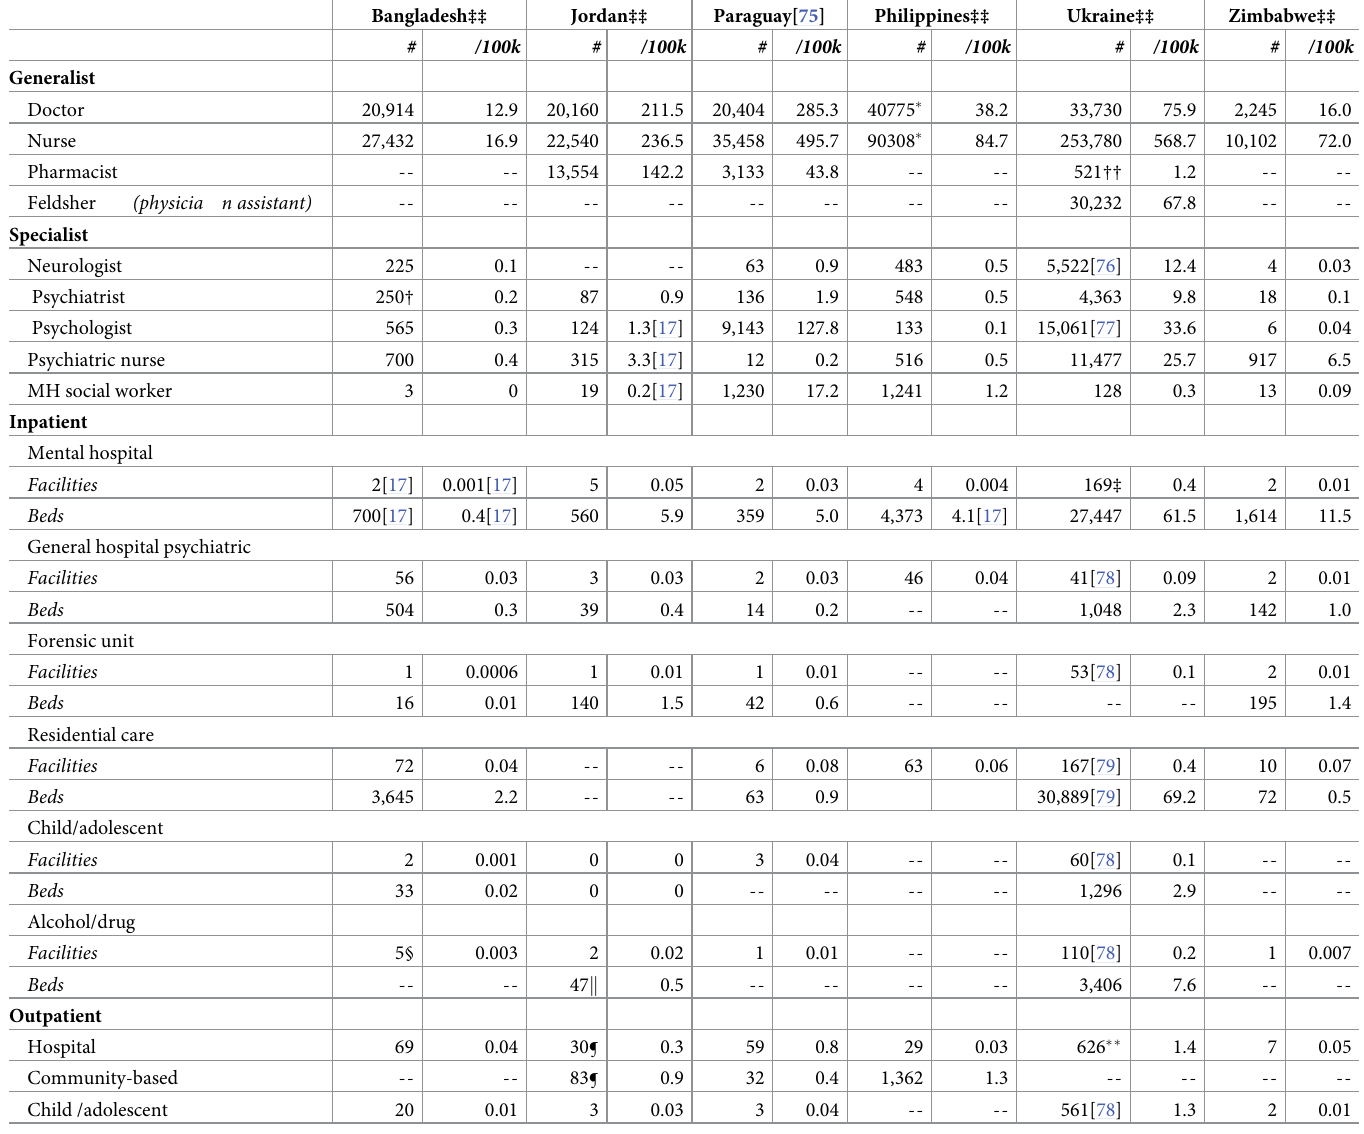
Table 4. Human resources and health facilities for mental